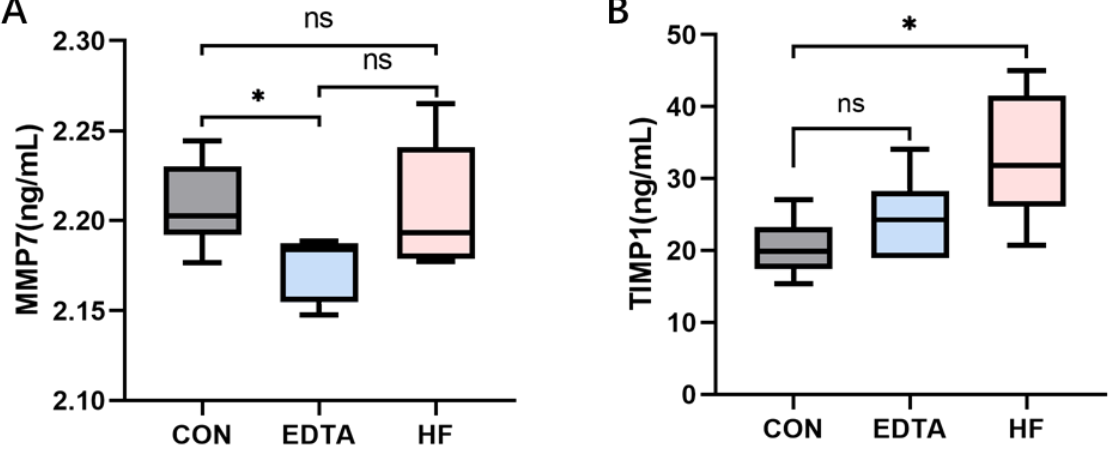
Figure 3. Levels of IL-6, TNF- α and IL-1 β in the serum of each group detected by ELISA. ( A ) Level of IL-6 in the serum of each group. ( B ) Level of TNF- α in the serum of each group. ( C ) Level of IL-1 β in the serum of each group. CON: control group, EDTA: experimental group, HF: recovery group. Statistically significant differences are indicated by * p < 0.05, ** p < 0.01.